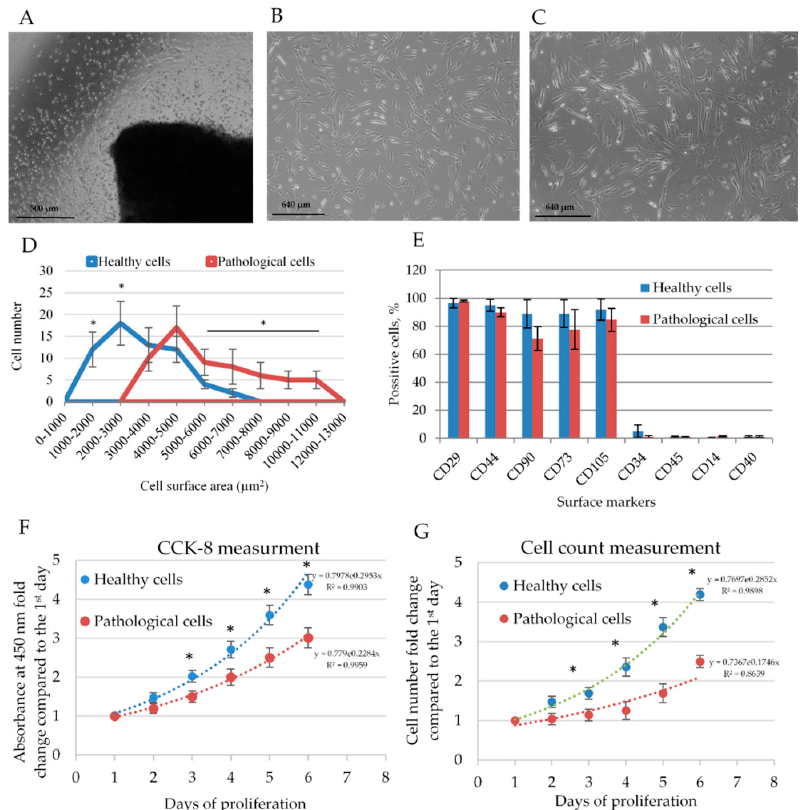
Figure 1. The phenotype and proliferation rate of healthy and pathological human myocardium-derived mesenchymal stromal cells (hmMSC). ( A ) Obtaining of hmMSC from the human heart explants after five days of cultivation, scale bar = 500 µ m. Morphology of healthy ( B ) and pathological ( C ) hmMSC, scale bar = 640 µ m. ( D ) Graphical representation of attachment area for healthy and pathological cell. The distribution of 60 cells of each type according to the attached area are presented. ( E ) Expression of surface markers on healthy and pathological hmMSC. The proliferation rate of healthy and pathological hmMSC evaluated by metabolic Cell Counting Kit-8 (CCK8) ( F ) and cell-counting method ( G ). Data are shown as mean ± standard deviation (SD). The * p ≤ 0.05, n = 6 from three experiments calculated by an Excel program. Total adherent surface of di ff erent cell types and the minor and major axes of healthy and pathological cells are presented as Supplementary Figure